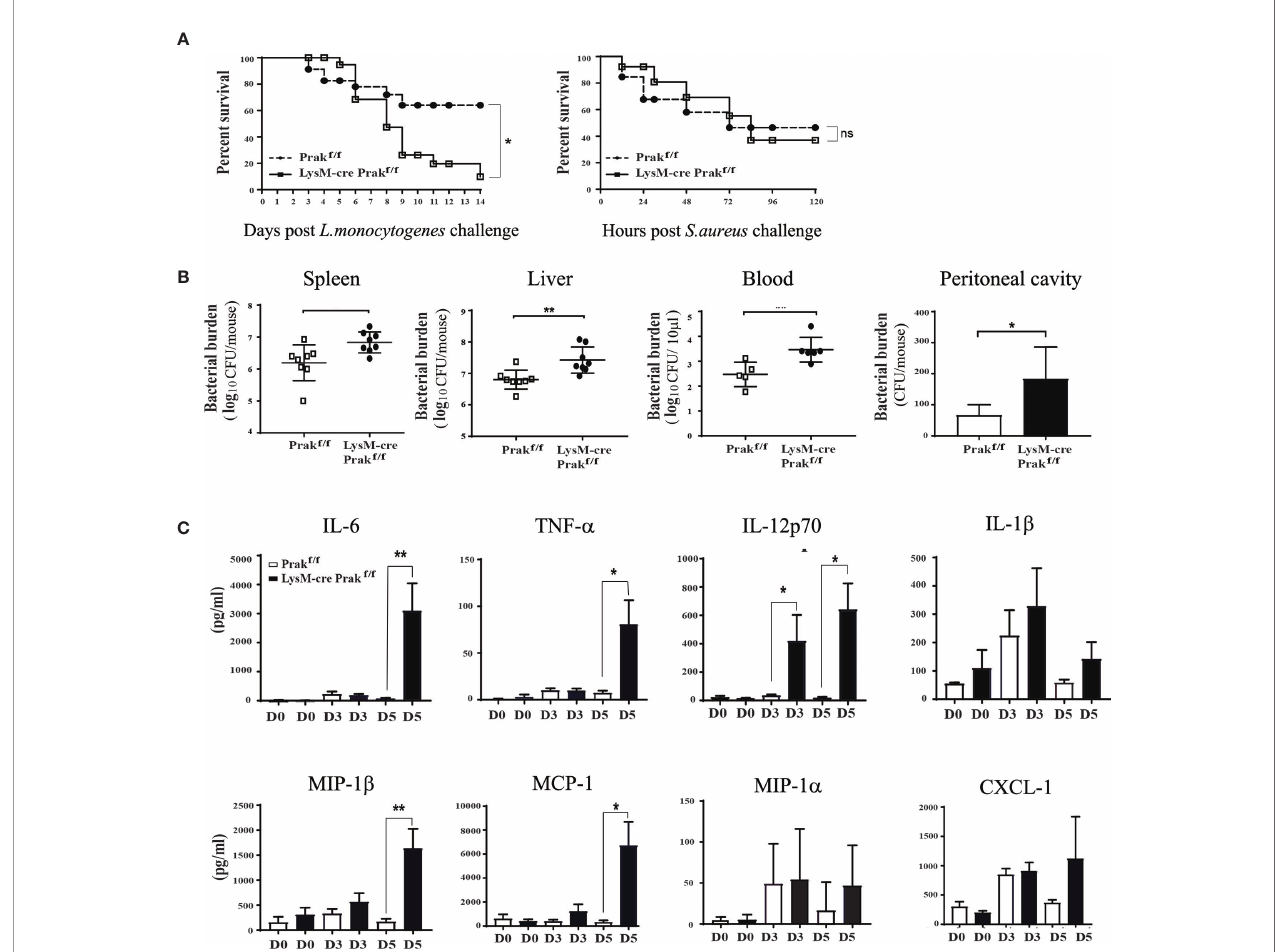
FIGURE 2 | Susceptibility of Prak-de fi cient mice to Listeria infection. (A) Prak- de fi cient and wild type mice were intraperitoneally inoculated with a lethal dose of Listeria monocytogenes (7.5×10 6 CFU, Left ) or Staphylococcus aureus (ATCC 8325) (8×10 7 CFU, Right ). The survival rate was monitored daily and analyzed using the log-rank test. Each group consisted of 24 mice. * P <0.05. (B) Following inoculation with a sub-lethal dose (5×10 6 CFU) of L. monocytogenes , the peritoneal lavage (n=3), peripheral blood (n=5), spleen (n=8) and liver tissues (n=8) were collected at day 3. Bacterial loads were measured using the colony forming assay. * P < 0.05; ** P < 0.01 by t -test. (C) Prak- de fi cient (n=13) and wild type mice (n=12) received intraperitoneal injections of L. monocytogenes (7.5 × 10 6 CFU). Serum samples were collected at day 0, 3 and 5, and the cytokine pro fi le was assessed with a Luminex assay. Data from three independent experiments are presented as mean ± SD. * P < 0.05; ** P < 0.01 by t -test. ns, not signi fi